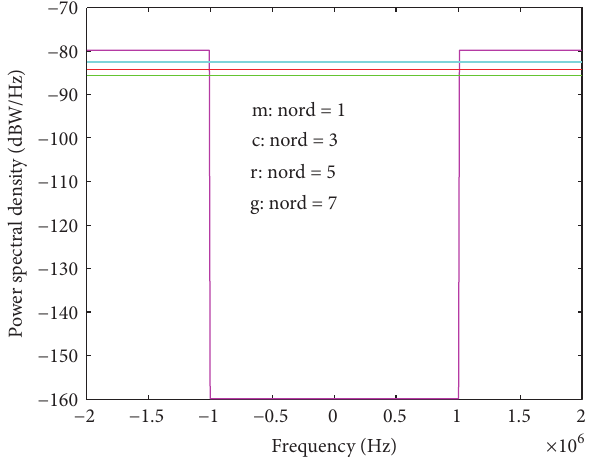
Figure 2: Power spectral density (dBW/Hz) of various order convolution terms ( 𝐵 𝑇 = 100 MHz, 𝐵 notch = 2MHz, and 𝜎 2 𝜉 = 1W).